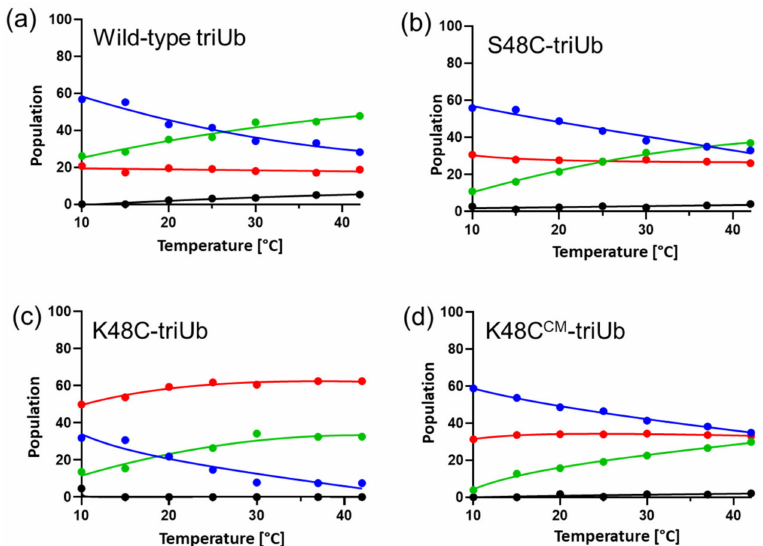
Figure 7. Quantitative estimation of the temperature-dependent populational shift of each conformer of triUb and its analogues. Temperature dependence of the open conformational population of ( a ) wild-type triUb, ( b ) K48S-triUb, ( c ) K48C-triUb, and ( d ) K48C CM -triUb. The calculated P A , P B , P C , and P D values are shown in blue, green, red, and black, respectively. The population of each temperature was estimated based on the dividing ratio of chemical shift differences of